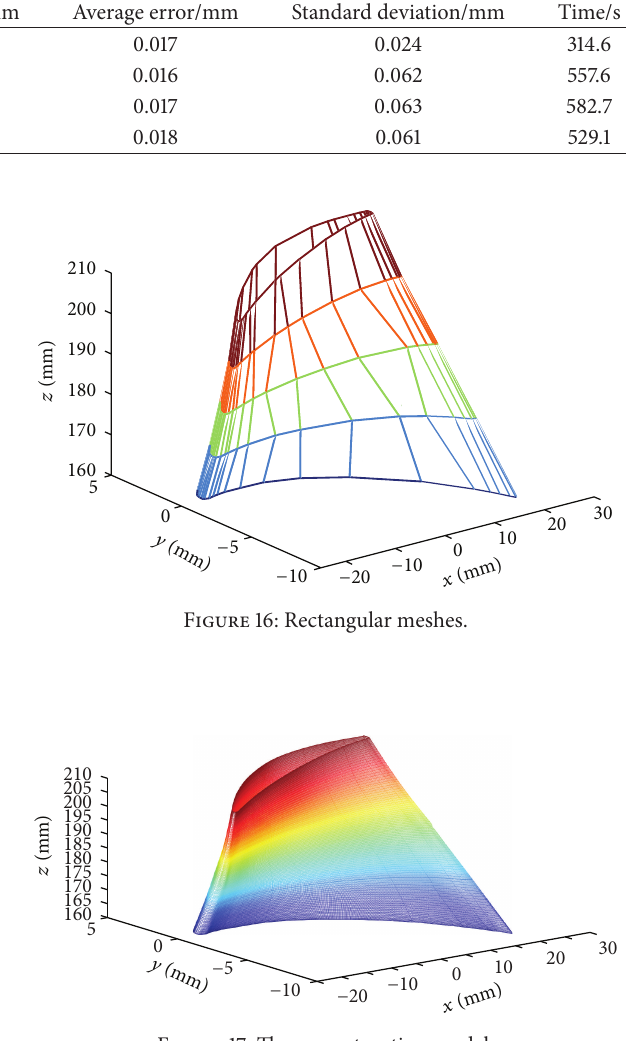
Figure 17: The reconstruction model.